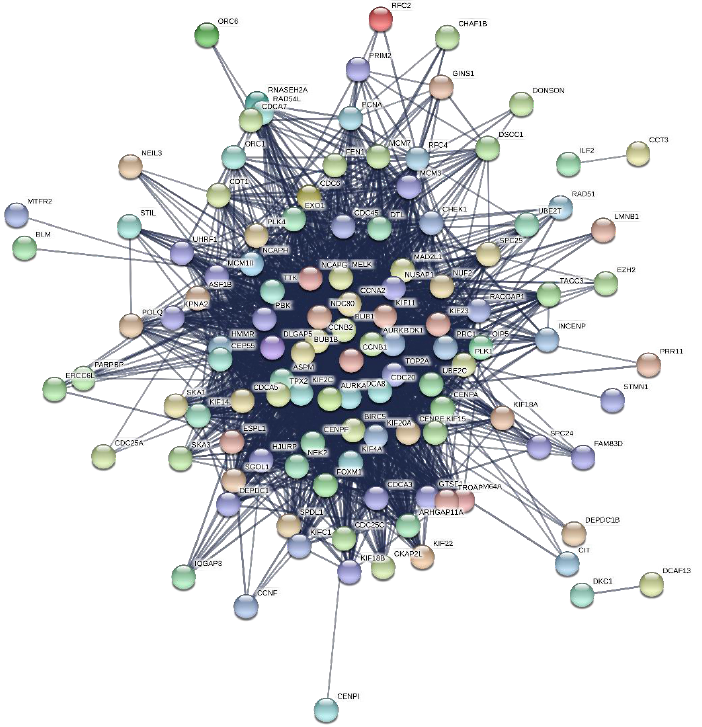
Figure 7. Visualization of the PPI network by Cytoscape.